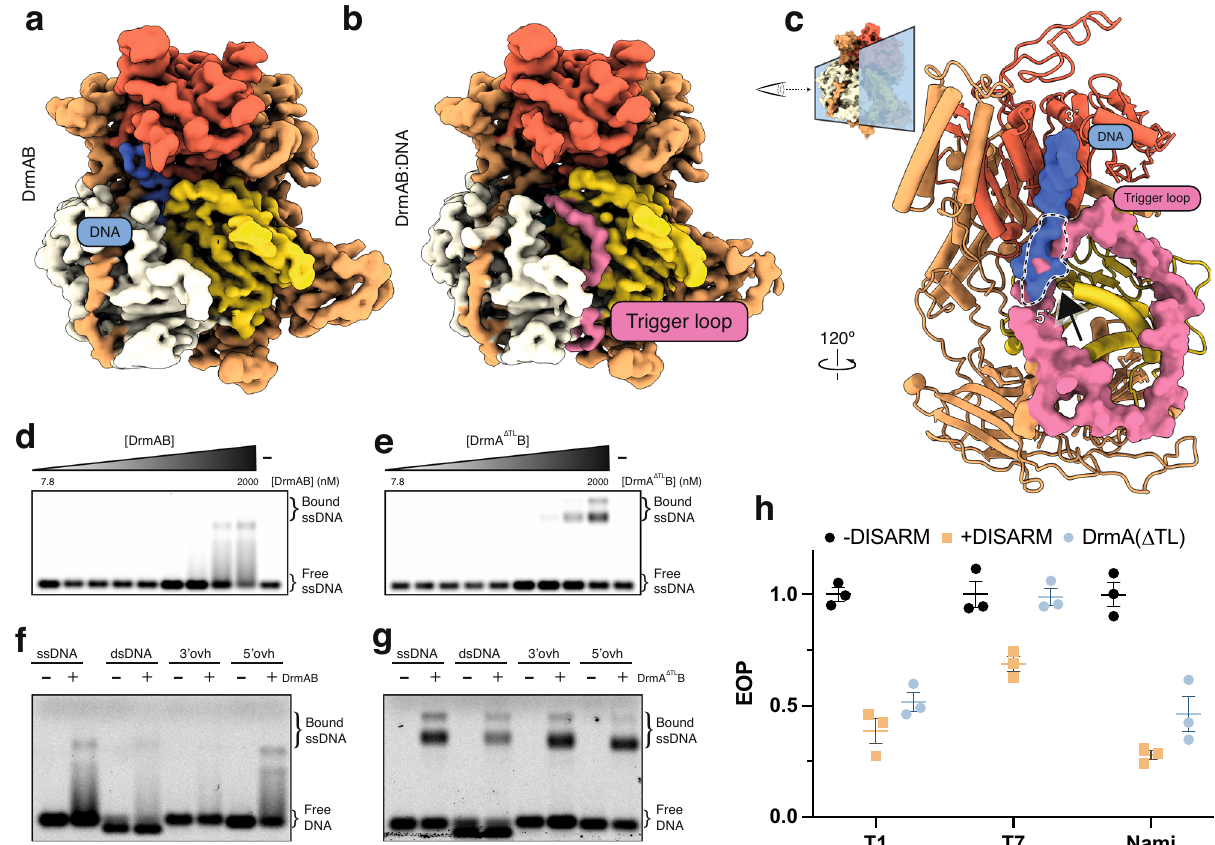
Fig. 3 DrmA trigger loop (TL) partially occludes DNA-binding site. a , b Cryo-EM reconstruction of apo DrmAB ( a ) and DNA-bound DrmAB ( b ). Density corresponding to DrmA trigger loop is shown in pink. DrmAB are colored by structural domains as shown in Fig. 1a. c Overlay of DrmAB-bound DNA (blue) and TL (pink) showing the steric clash (dashed black & white outline). TL partially occludes DNA-binding site. DrmB and parts of DrmA have been omitted for clarity. Graphic at the top right shows how the view in ( c ) is related to the structures in panels ( a , b ). d , e EMSA analysis of DrmAB and DrmA( Δ loop)B binding DNA. The smeared bands that occur at high concentrations of DrmAB correspond to bound DNA dissociating from the complex. This did not occur for DrmA( Δ loop)B, and an additional super-shift was present, corresponding to multiple copies of DrmA( Δ loop)B binding to the same 75-nt DNA concurrently. The free DNA marker is 75-nt in length. Representative of three independent experiments. Source Data are provided as a Source Data fi le. f , g DNA substrate preferences of DrmAB and DrmA( Δ loop)B. The 75-nt Cy5-labeled DNA (ssDNA) was annealed to complementary oligos corresponding to the full sequence (dsDNA), or 20 bases at the 5 ’ or 3 ’ ends (3 ’ ovh and 5 ’ ovh, respectively). DrmAB showed a preference for ssDNA and 5 ’ ovh DNA, whereas DrmA( Δ TL)B bound to all DNA substrates tested. The free DNA marker is 75-nt in length. Representative of three independent experiments. Source Data are provided as a Source Data fi le. h Effect of truncation of TL on DISARM anti-phage activity. Points correspond to three biological replicates, with mean and standard deviation shown. Source Data are provided as a Source Data fi